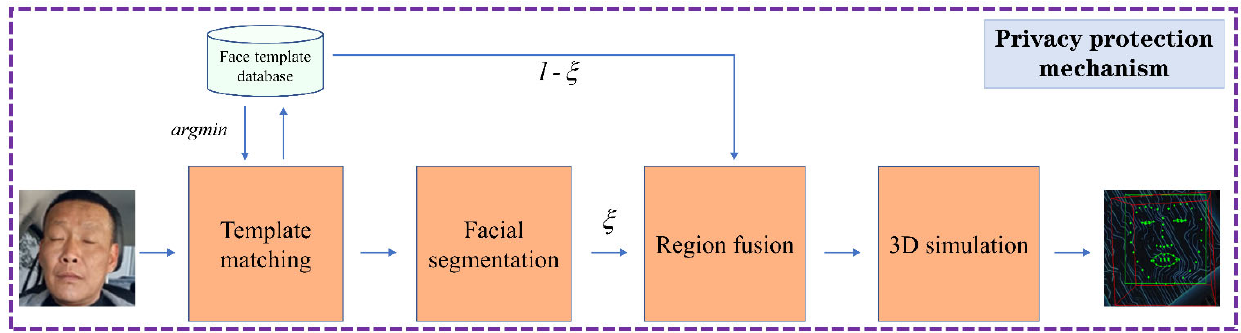
Figure 2. Schematic diagram of privacy protection mechanism.